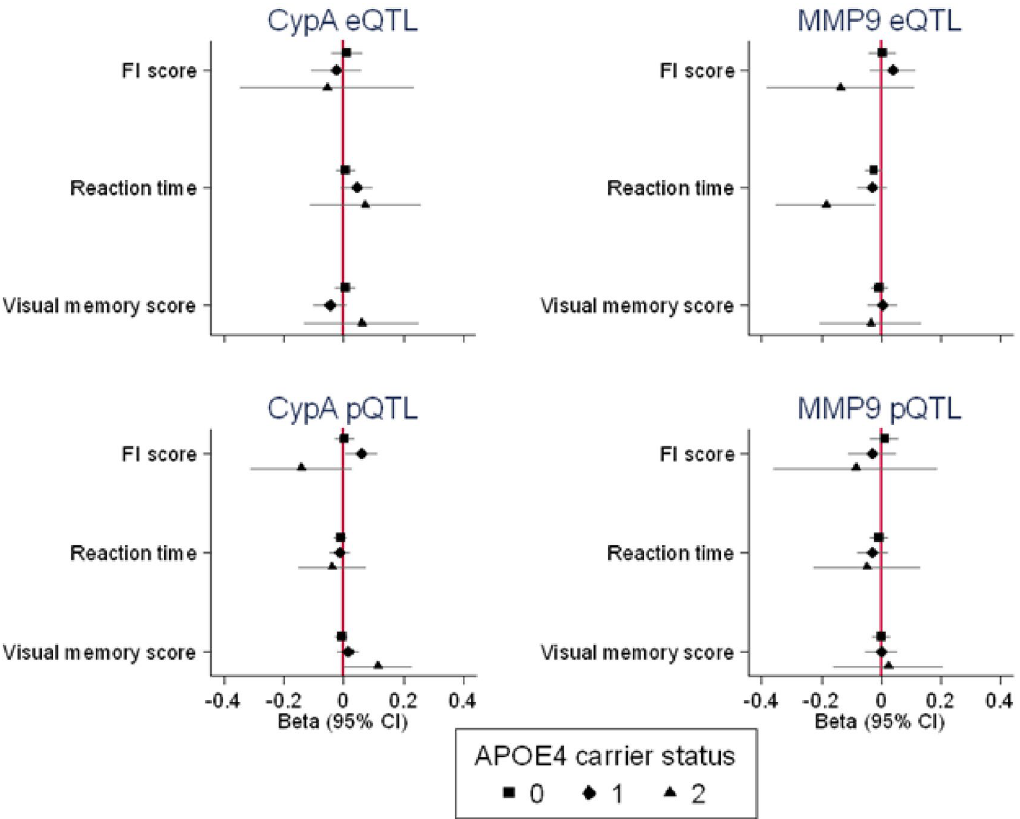
Figure 2. Causal effects of CypA and MMP9 eQTL and pQTL PRSs on the continuous cognitive function outcomes in the UK Biobank (fluid intelligence score, reaction time and visual memory) in the oldest tertile, by APOE4 carrier status. All outcomes are in standard deviation units and higher values represent poorer